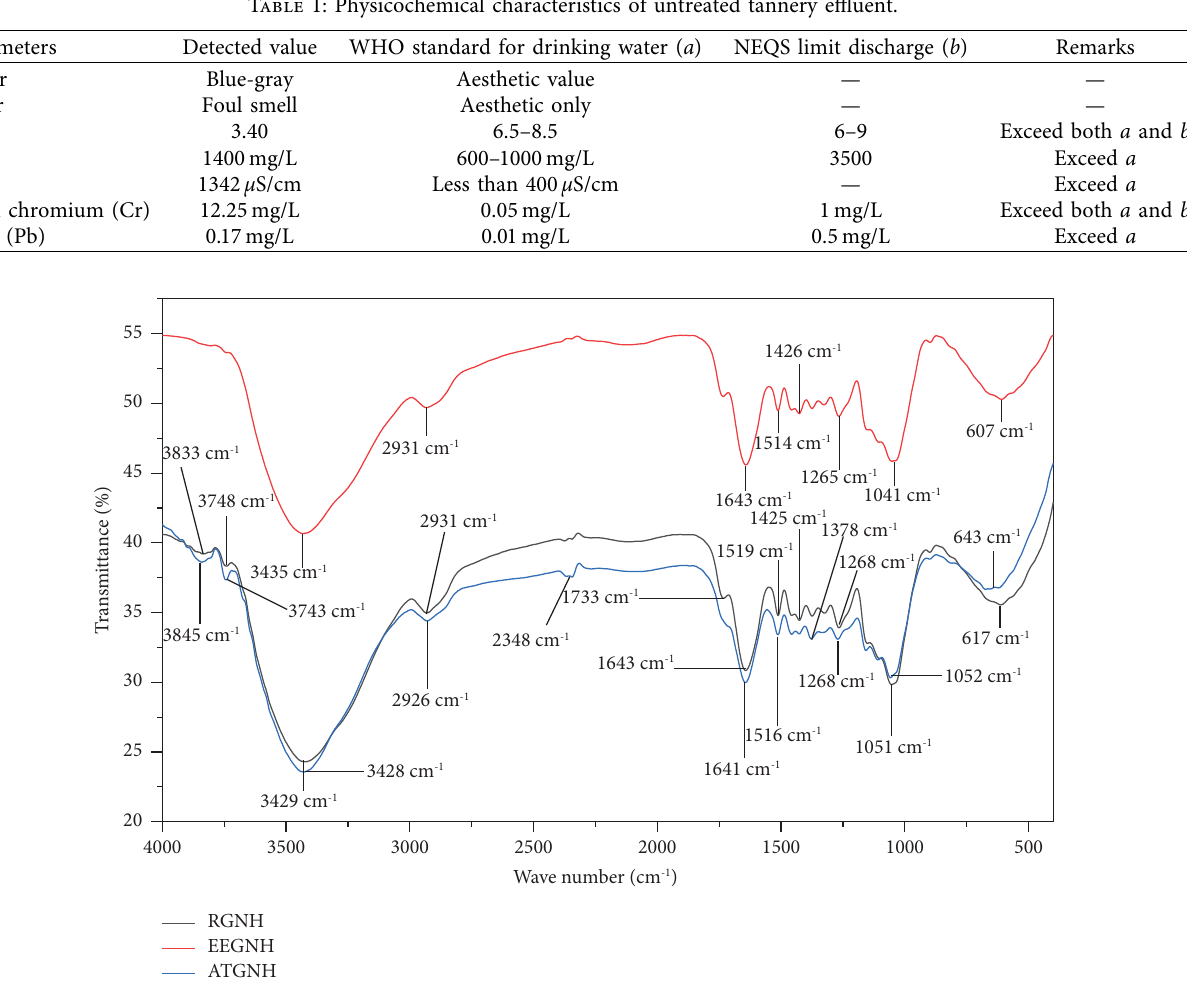
Figure 1: FTIR analysis of raw, ethanol-extracted, and acid-treated groundnut husk. Table 2: Functional groups of groundnut husk with or without chromium-loaded and the corresponding infrared absorption wavelengths. Observed peak wavelength (cm − 1 ) Wavelength range (cm − 1 ), intensity, and